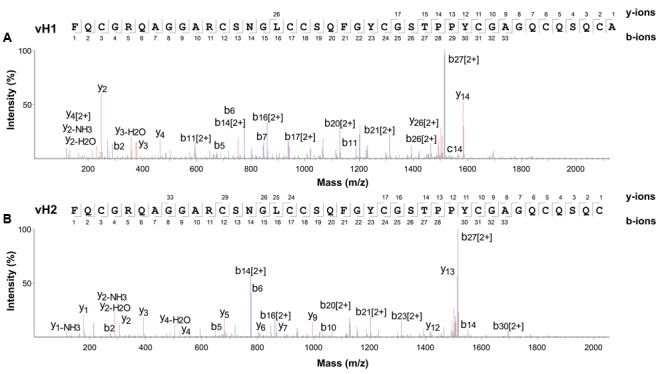
Mass spectra of vaccatides from LC-ESI-LTQ-Orbitrap MS/MS in positive ion mode. Vaccatide (A) vH1 and (B) vH2 were S-reduced by 20 mM dithiothreitol, S-alkylated with 200 mM iodoacetamide and subsequently desalted by C18 Ziptip. The spectrum was scanned between mass ranges of 100 and 1800 m/z. Assignment of isobaric aa (Lys/Gln and Ile/Leu) were confirmed by transcriptome data.